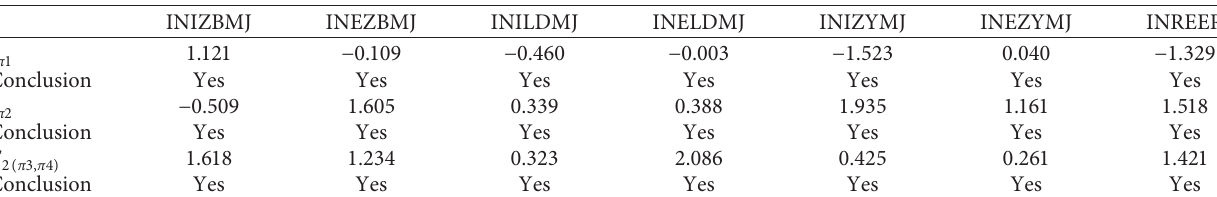
Figure 1: Seasonal characteristics of import and export trade of different types of products between China and the United States. Table 3: HEGY test